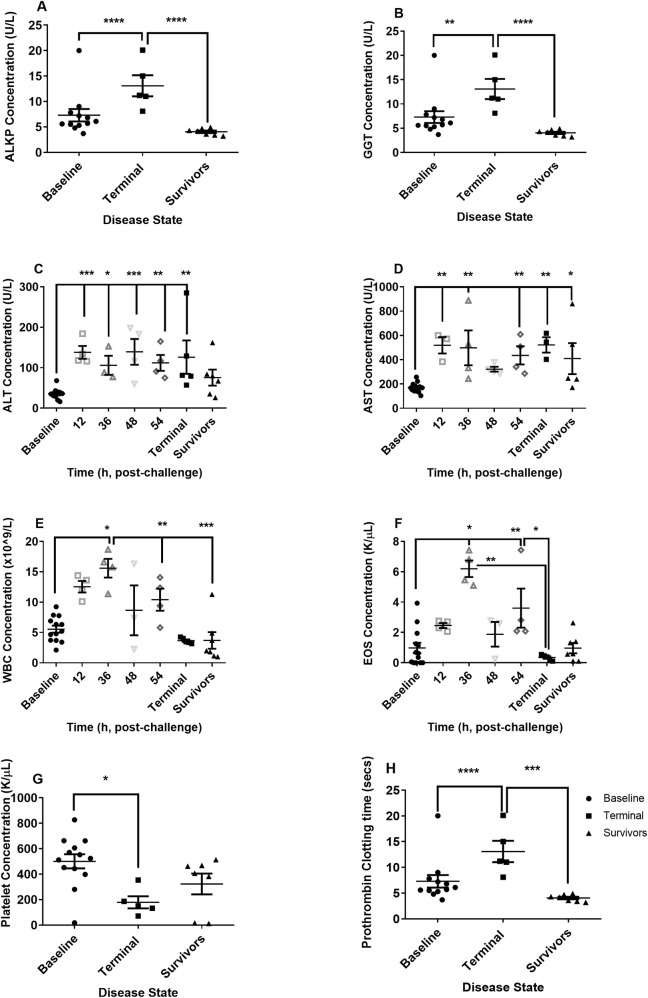
Clinical chemistry and haematological parameters observed in marmosets at the time of euthanasia following challenge with between 6.2 and 8.1 x 106 cfu of B. pseudomallei by the ingested route.A ALKP (Alkaline phosphatase U/L) levels from the dose-ranging study, B GGT (Gamma-glutamyl Transferase U/L) levels from the dose-ranging study, C ALT (Alanine transaminase U/L), D AST (Aspartate aminotransferase U/L), E WBC (White Blood Cell Count x 109/L), F EOS (Absolute eosinophil count, K/μL), G PLT (Platelets K/μL), H Prothrombin time (Secs) levels from the dose-ranging study. For C to G data from Study 1 (dose-ranging) and Study 2 (natural history) having been included for comparison purposes.